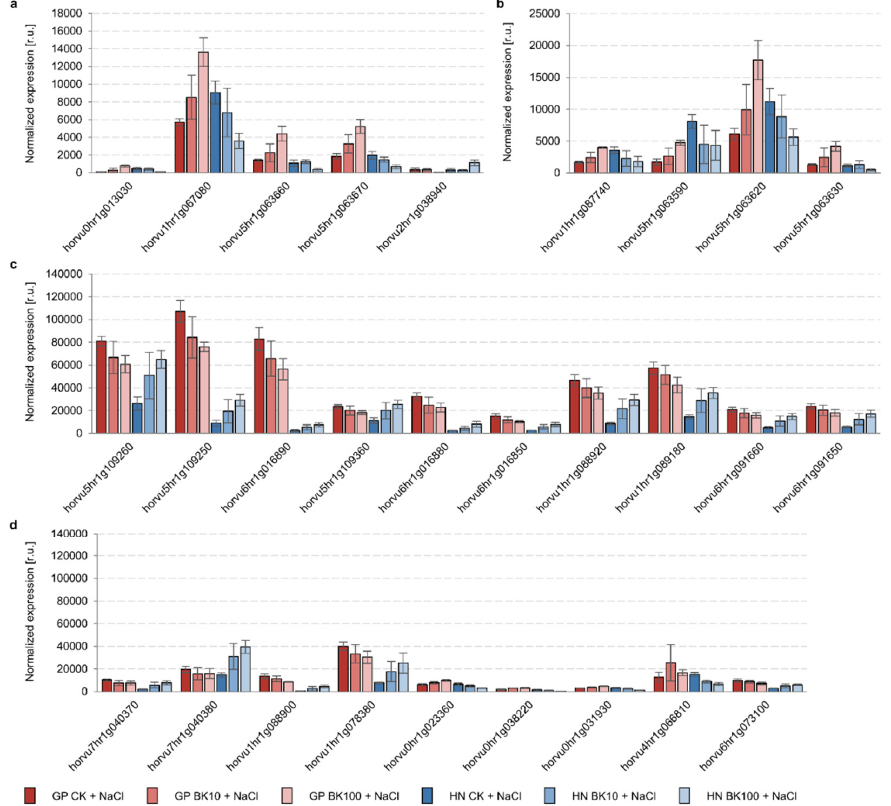
Figure 8. Differentially expressed genes (DEGs) involved in photosynthesis identified in leaves (3rd and 4th) of two barley cultivars, i.e., Golden Promise and Haruna Nijo, after bikinin treat- ment, identified in both cultivars ( a ), in Golden Promise ( b ), and in Haruna Nijo ( c , d ). DEGs were identified via bioinformatic analysis of three biological replicates of each sample and log2-fold change (<1 and < − 1) and Padj < 0.01. Identified DEGs encoding ( a ) LHC-related protein (ELIP) (horvu0hr1g013030, horvu1hr1g067080, horvu5hr1g063660, horvu5hr1g063670) and component PsbR of PS-II complex (horvu2hr1g038940); ( b ) LHC-related protein (ELIP) (horvu1hr1g087740, horvu5hr1g063590, horvu5hr1g063620, horvu5hr1g063630); ( c ) component LHCb1/2/3 of the LHC-II complex (horvu5hr1g109260, horvu5hr1g109250, horvu6hr1g016890, horvu5hr1g109360, horvu6hr1g016880, horvu6hr1g016850, horvu1hr1g088920, horvu1hr1g089180, horvu6hr1g091660, horvu6hr1g091650); and ( d ) component LHCb1/2/3 of the LHC-II complex (horvu7hr1g040370, horvu7hr1g040380, horvu1hr1g088900, and horvu1hr1g078380), LHC-related protein (ELIP) (horvu0hr1g023360, horvu0hr1g038220, horvu0hr1g031930, and